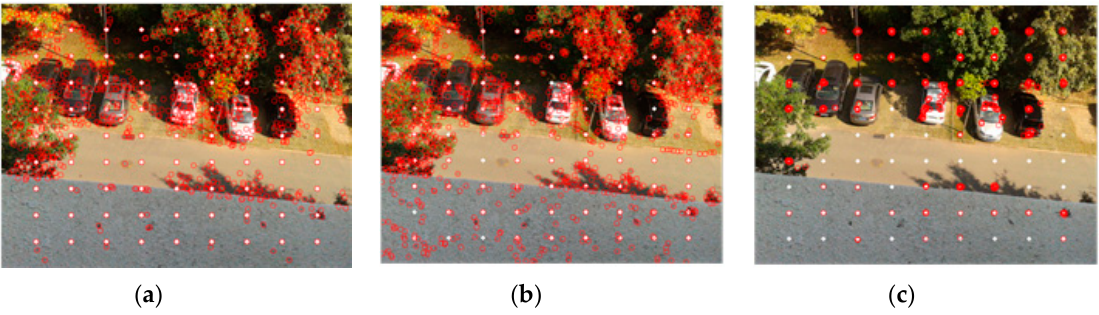
Figure 6. Testing results for ( a ) speed and ( b ) accuracy in feature point detection.